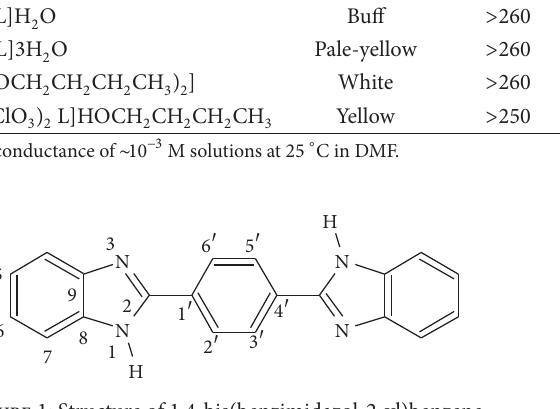
T 1: Physical properties and analytical data of the complexes. Color